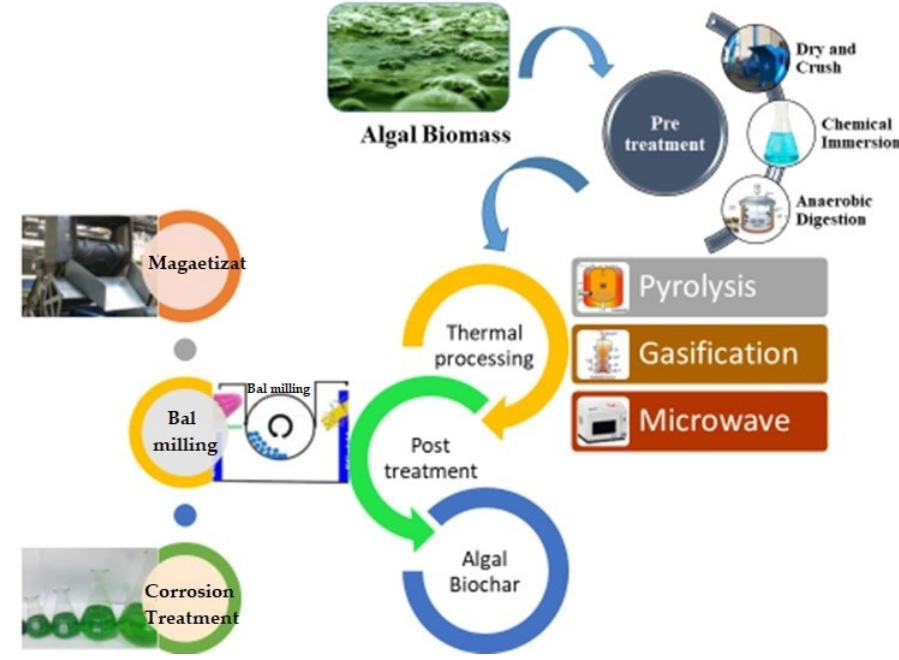
Figure 2. Production of phycochar from algal biomass by different methods. Table 3. Chemical analysis of algal biochar. Note that all the values are in percent (%). Algae Carbon Nitrogen Oxygen